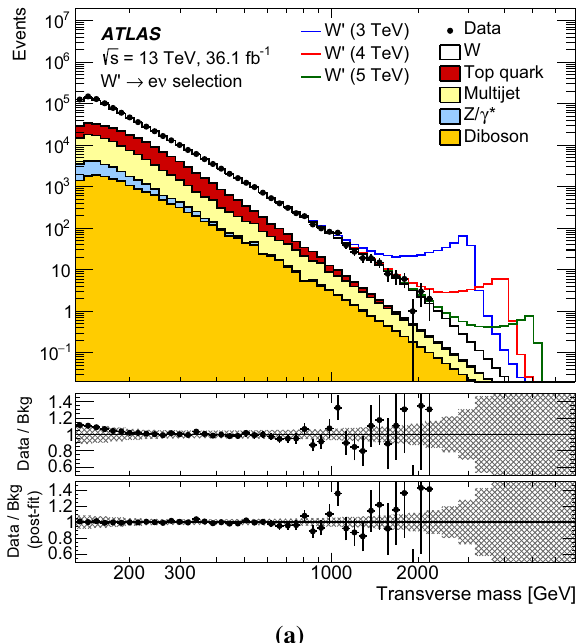
Fig. 1 Transverse mass distributions for events satisfying all selec- tion criteria in the a electron and b muon channels. The distributions in data are compared to the stacked sum of all expected backgrounds. As examples, expected signal distributions for three different SSM W (cid:2) boson masses are shown on top of the SM prediction. The bin width is constant in log ( m T ) . The middle panels show the ratios of the data